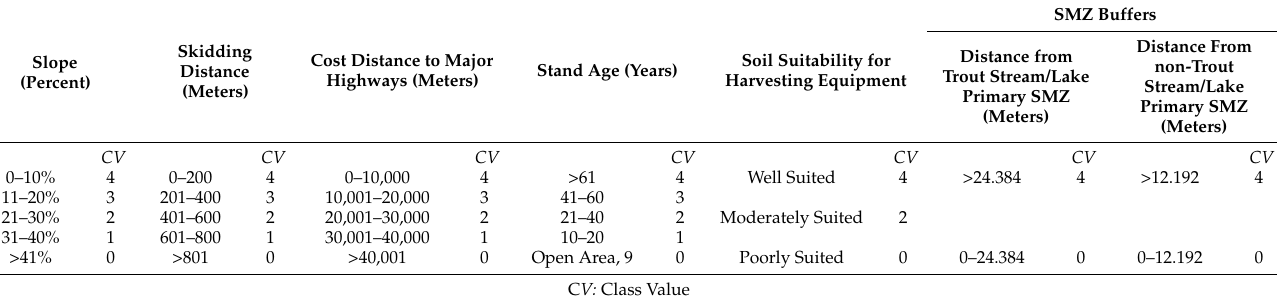
Table 3. HOI criteria and their 0–4 class